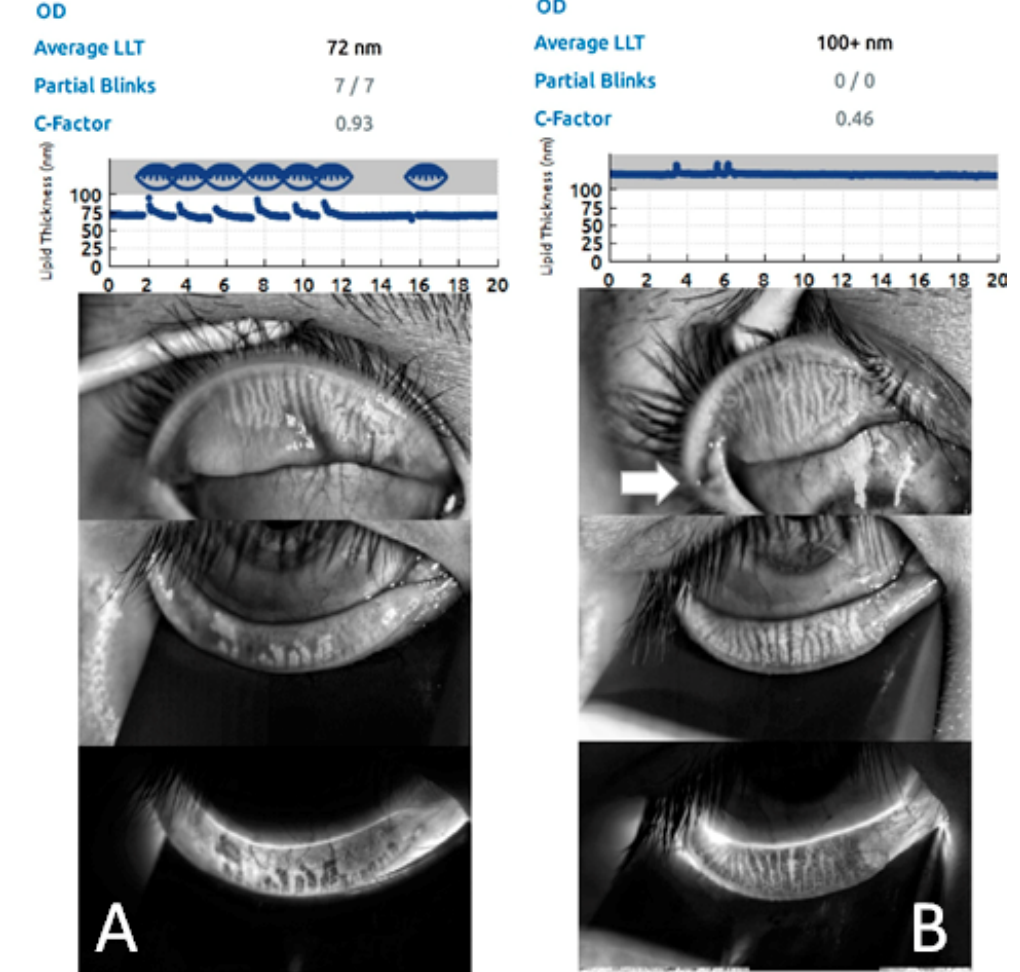
Figure 3. Blinking efficiency improved after the LTF procedure. Before the procedure, there were significantly Meibomian gland drop-outs both in the upper and lower lids with several partial blinks (incomplete blinking) ( A ). Three months after the procedure (the LTF was marked by the arrow), blinking efficiency was significantly improved with fewer meibomian gland drop-outs and no incomplete blinking ( B ).